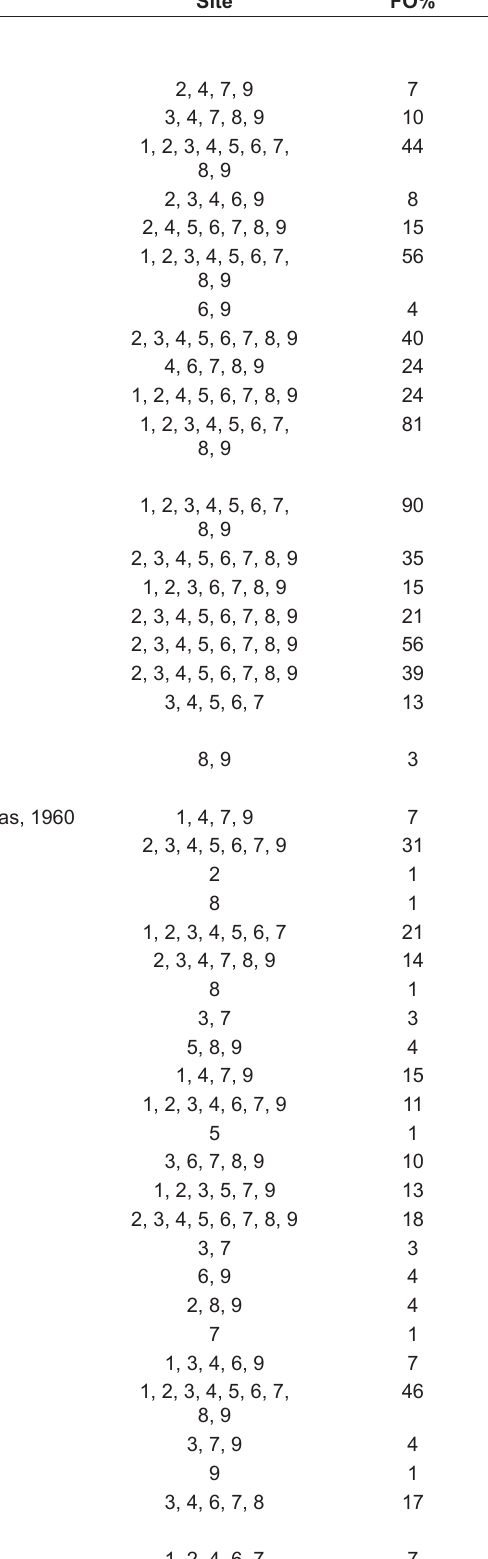
Table 2. Taxonomic composition, site occurrence and frequency of occurrence (FO%) of zooplankton in the Aporé River, Paranaíba River